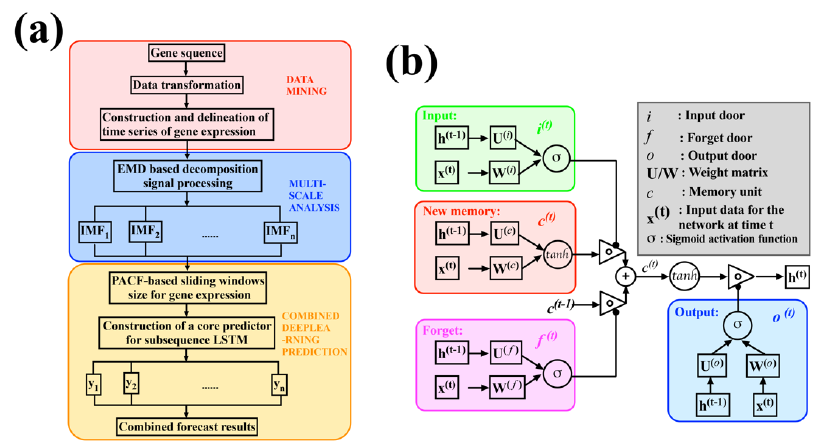
Figure 1. Multi-LSTM flowchart. ( a ): Flowchart of data processing. Step 1: Data mining. RNA deg- radation-related genes and the expression corresponding to each time are extracted and normalized.